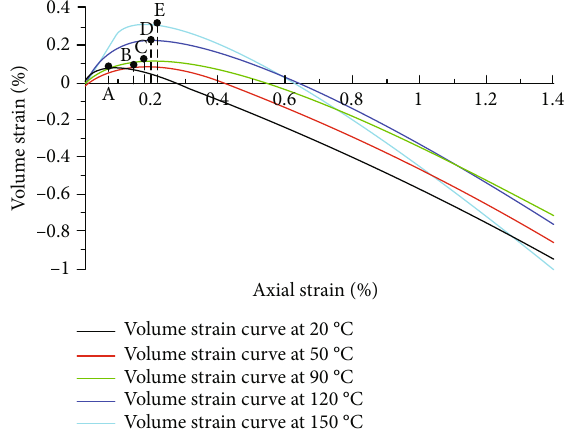
Figure 6: Volume strain simulation curves of salt rock samples at di ff erent temperatures.